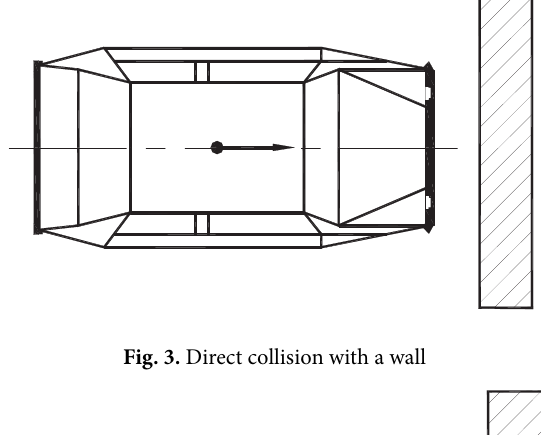
Fig. 4. Angular collision with a wall